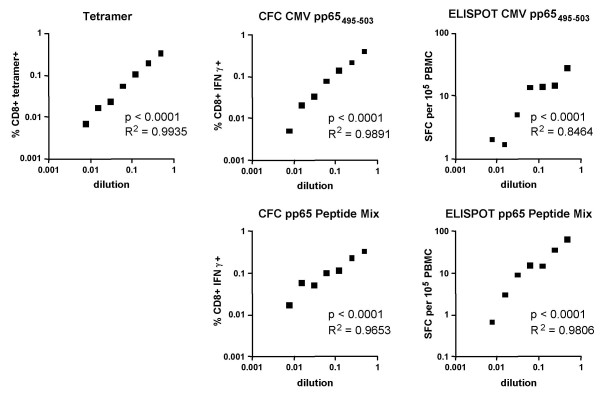
Linearity of assays. Triplicate samples of PBMC from a HLA-A2+ high-responding donor (#43) were serially diluted into PBMC from a known HLA-A2+ non-responder. The same non-responding donor was used for all assays. Unstimulated background was subtracted for each dilution point in CFC and ELISPOT assays. This background was uniformly low (< 0.08% for CFC and < 15 SFC per 2.5 × 105 PBMC for ELISPOT) despite the used of allogeneic PBMC for the dilution. Note that the pp65495–503 peptide response of this donor (#43) was much lower in ELISPOT compared to the other two assays.